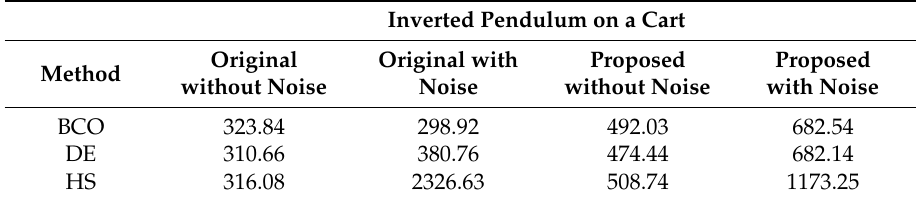
Table 13. Comparison of the time obtained from the inverted pendulum controller for the original and proposed algorithms.